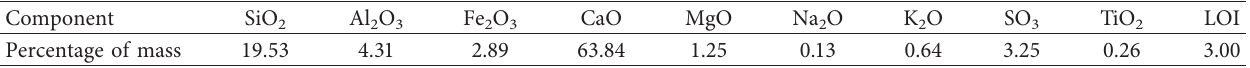
Table 1: Chemical compositions of cement.